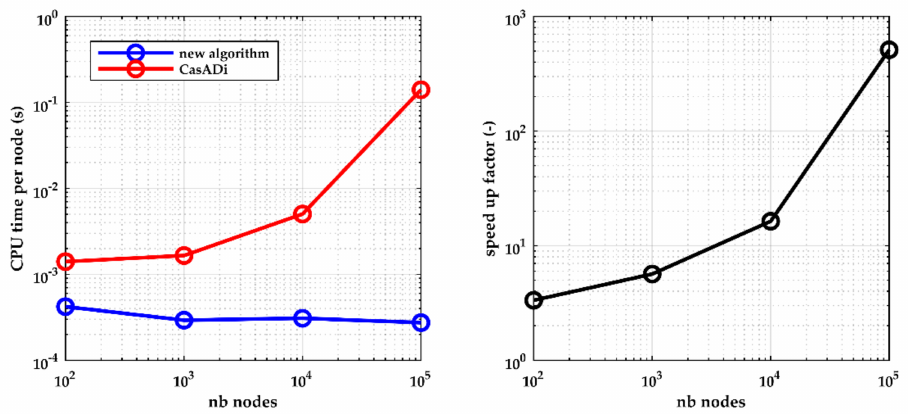
Figure 13. Comparison of the CPU time evolution with the number of nodes between our algorithm and CasADi and the associated speed up